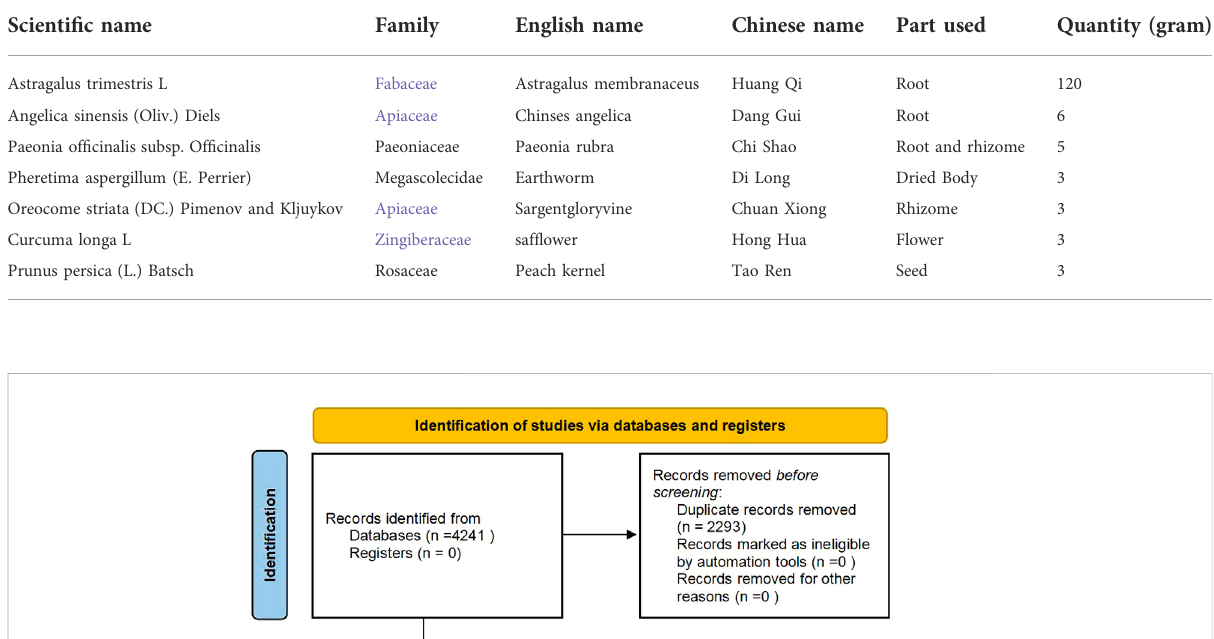
TABLE 1 Components of buyang huanwu decoction.